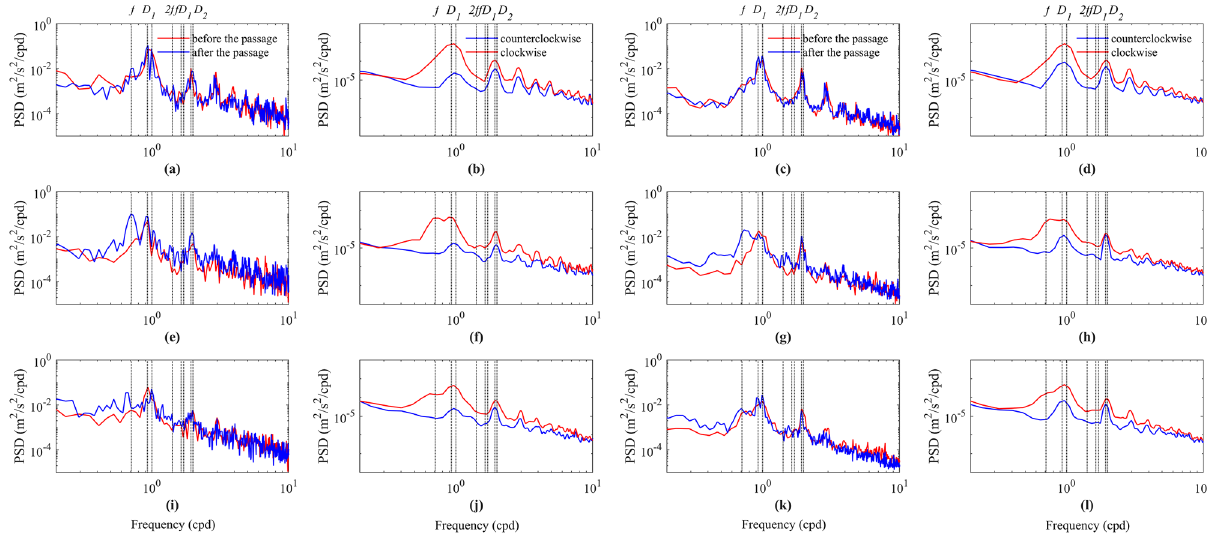
Figure 3. Depth-averaged power spectra and rotary spectra of observed current velocity in the thermocline ( a,b,e,f,i,j ) and subthermocline ( c,d,g,h,k,l ) the lower boundary of thermocline during the passage of typhoons Bebinca ( a–d ), Barijat and Mangkhut ( e–h ), and Yutu ( i–l ), respectively. Here and subsequently, the eight black vertical lines from the left to the right in each subfigure denote where the frequencies of depth-averaged near- inertial oscillation in the whole water column, O 1 , K 1 , 2 f, f O 1 , f K 1 , M 2 and S 2 tidal constituents are situated, respectively. The frequency bands from O 1 to K 1 , from f O 1 to fK 1 , and from M 2 to S 2 are defined as D 1 , f D 1 and